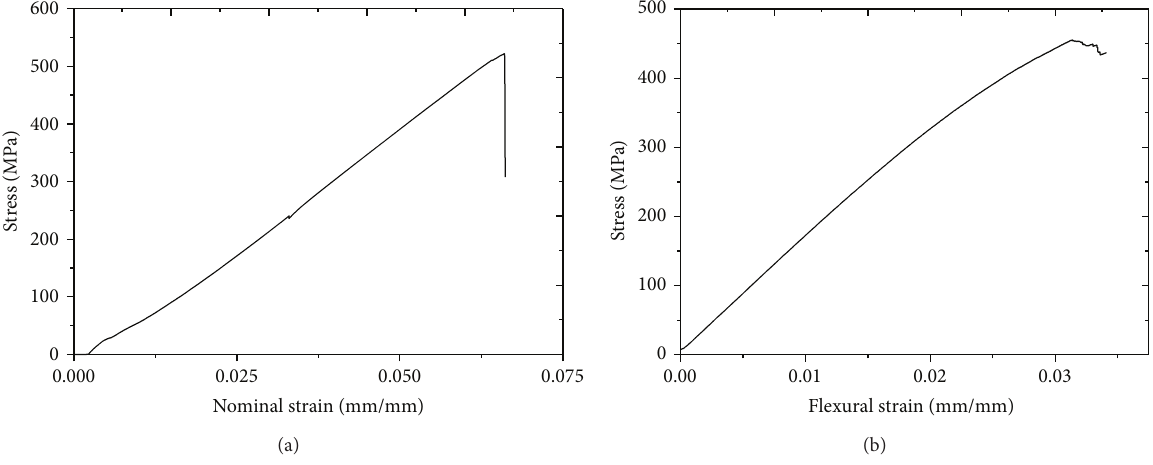
Figure 7: Stress-strain curves for BFPC: (a) tensile test; (b) flexural test.